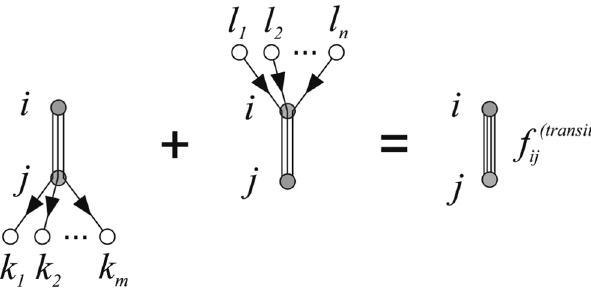
Figure 2. Graphical presentation of the summations in Eq.